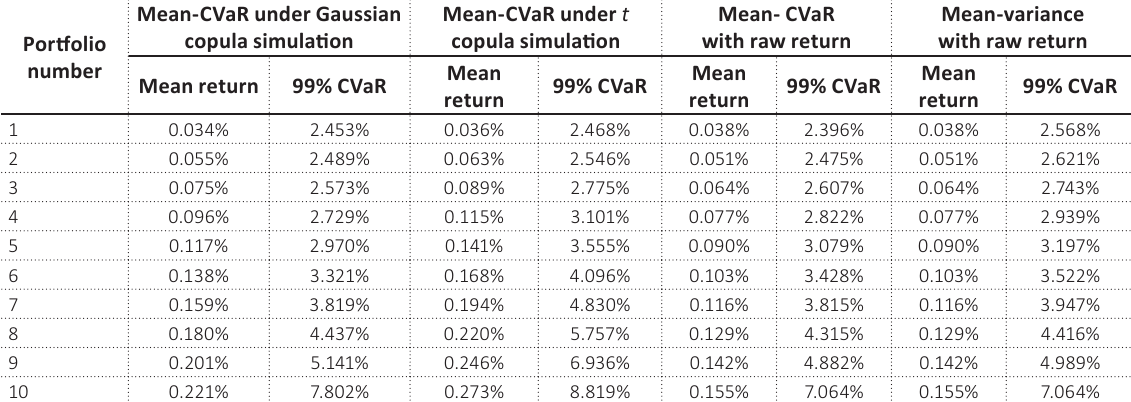
Figure 5. Mean-CVaR efficient frontiers with 99% CVaR (6.5-year duration) Table 6. Mean returns and 99% CVaR of 10 portfolios in each case (23 random